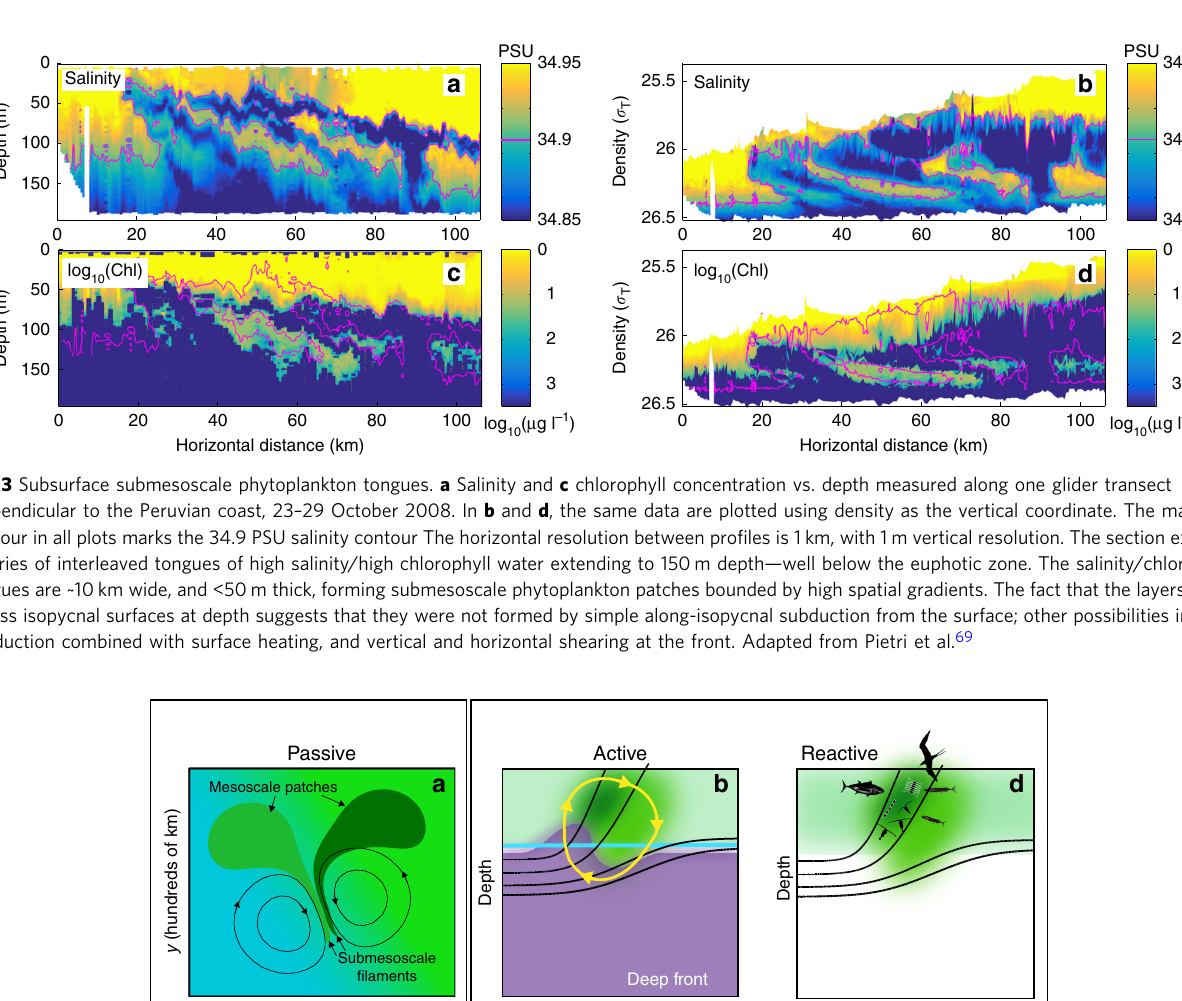
latitude and high-latitude, wintertime convective mixing brings nutrients into the euphotic zone, and these are consumed when light conditions become favorable, leading to strong seasonality in imum; it is in only in summer that the environment is oligo- trophic, i.e. that the euphotic layer is deprived of nutrients. In contrast, the subtropics are oligotrophic “ ocean deserts ”— despite